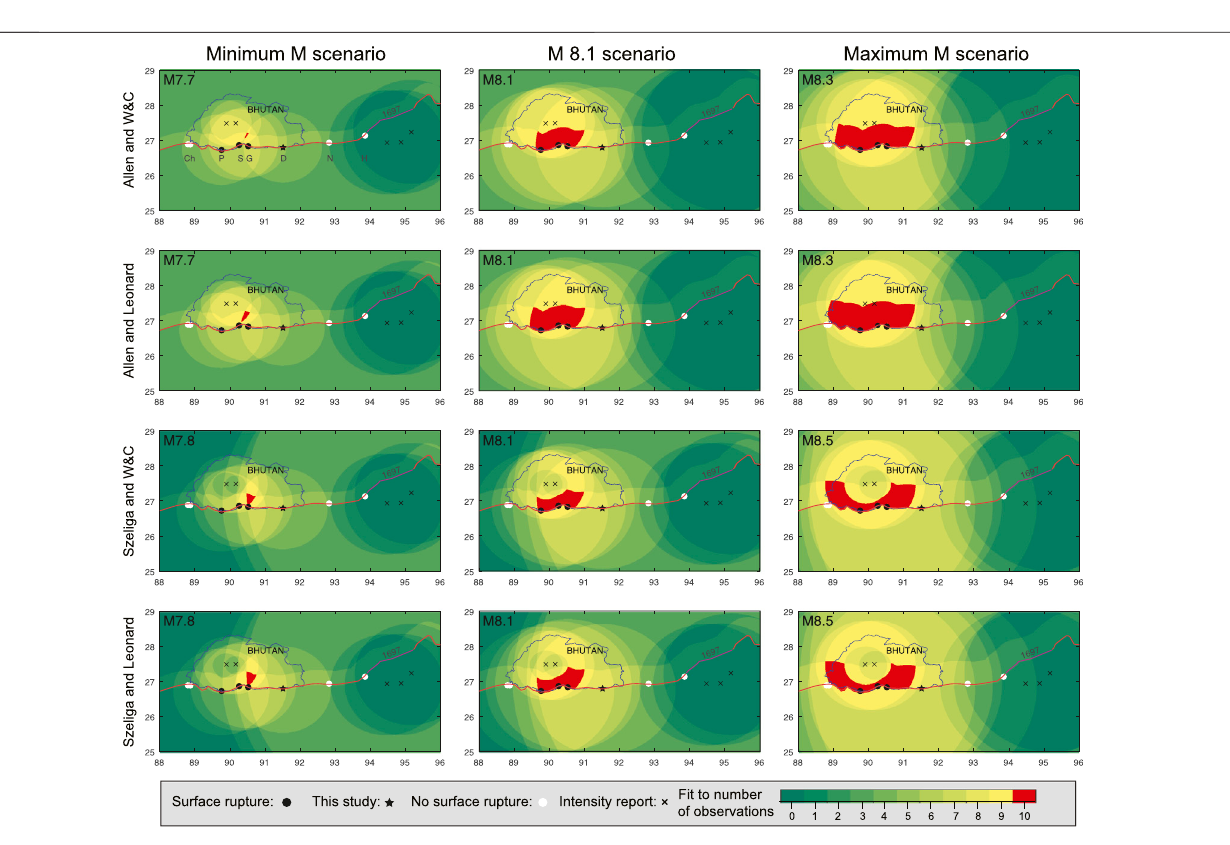
FIGURE 9 | Various earthquake scenarios fi tting historical damage and paleoseismology observations. Rows correspond to the different combinations ofintensity predictionequationsbyAllenetal.(2012)andSzeligaetal.(2010)combinedwithscalingrelationshipequationsbyLeonard(2010)andWellsandCoppersmith(1994),as explained in Hetényi et al. (2016). The three columns show minimum magnitude, M8.1, and large magnitude scenarios, respectively. The color bar shows the number of observations fi tted at the location on the map for a given magnitude; the red area represents hypocentre locations fi tting all observed data points. Palaeoseismologicaltrenches wheresurfacerupturecaused bythe1714earthquake wasidenti fi edareshowninblack circles;trenchesshowingnoevidenceofsurface rupture in the 18th century are shown as white circles. Ch : Chalsa; P : Piping; S : Sarpang; G: Gelephu; D: Dungsam Chu; N : Nameri; H : Harmutty. Intensity reports (Hetényi etal.,2016)areindicatedwithblackcrosses.Redlineisthesimpli fi edtraceoftheMainFrontalThrust.Purple segmentintheeastisthemaximumportion ofthe MHT ruptured by the 1697 Sadiya earthquake (Pandey et al., 2021). Bhutan ’ s approximate border is shown in blue for reference. Map coordinates are in degrees N and